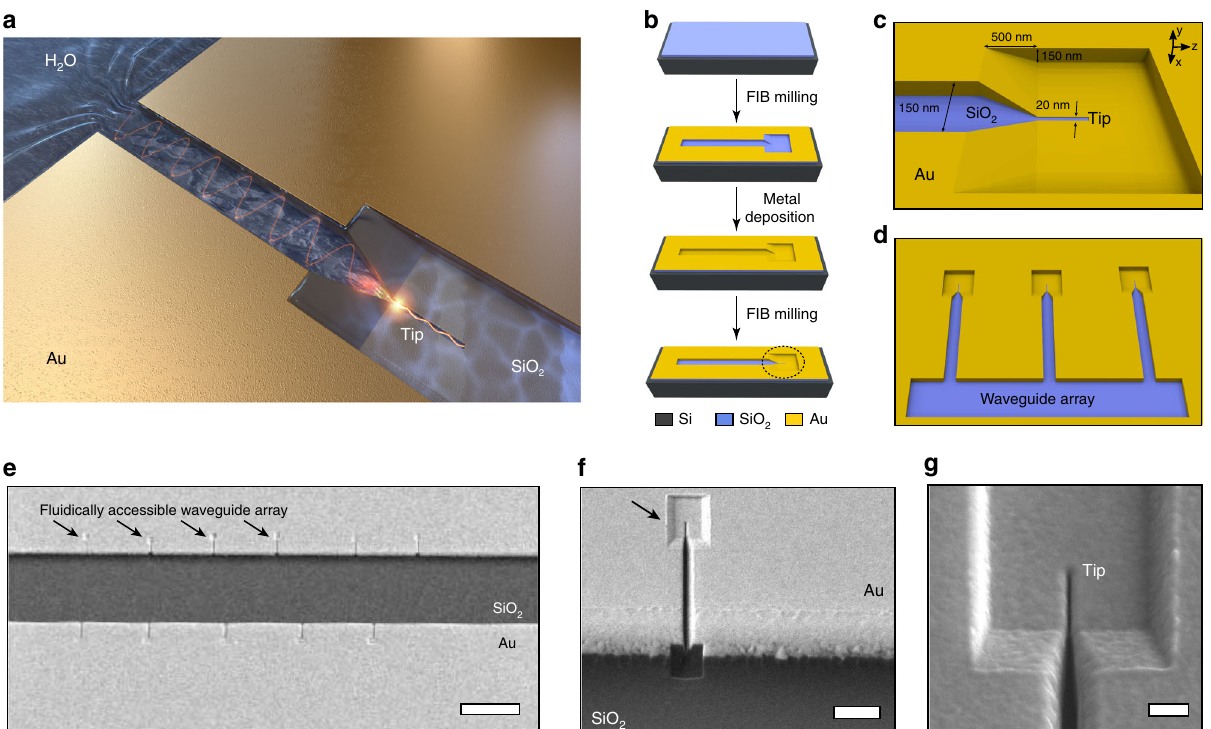
Fig. 1 Fabrication of 3D-tapered gap plasmon nanocavities. a Overview image of the device with plasmonic wave propagation and con fi nement at the end of three-dimensionally tapered tip. Open cavity allows fl uidic delivery and surface functionalization enabling molecular capture. b Device fabrication using a silicon wafer with 1 μ m thick thermally grown silicon dioxide, gold deposition, and FIB milling. c Zoomed-in view of the 3D-tapered nanocavity tip. d Schematic showing an array of 3D-tapered nanocavities with a hydrophilic silica base. e SEM image showing fabricated arrays of 3D-tapered nanocavities with hydrophilic silica base. Scale bar is 25 µ m. f A single 3D-tapered nanocavity. Scale bar is 2 µ m. g Sharp 3D-tapered naocavity tip. Scale bar is 200